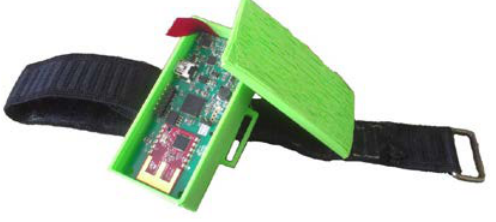
Figure 2. IMU sensor in its 3D printed case w/ Velcro strap.